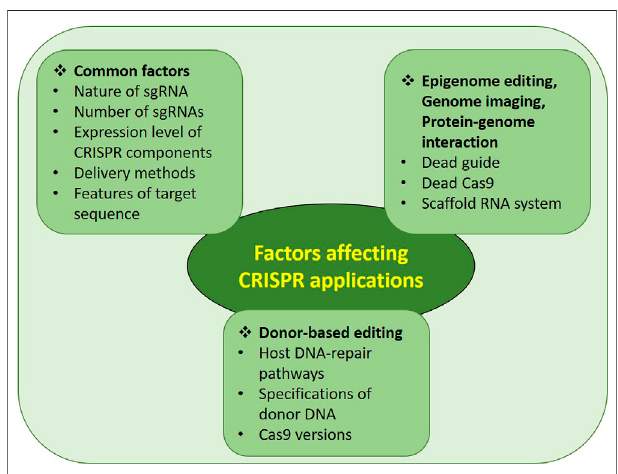
FIGURE 4 | Factors affecting ef fi ciency and speci fi city of CRISPR/Cas system.